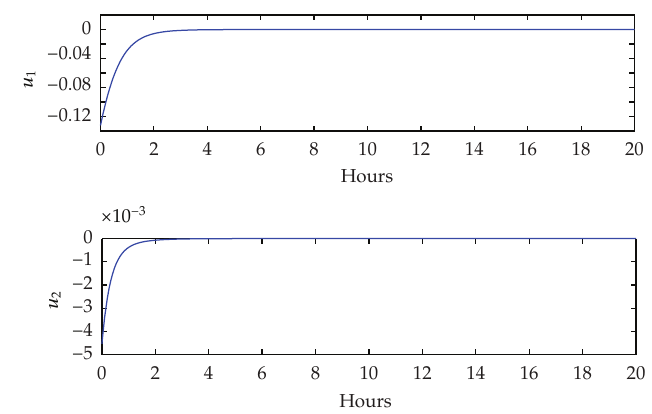
Figure 1: The optimal control graph for the two controls, namely, immune boosting and pathogen sup- pressing